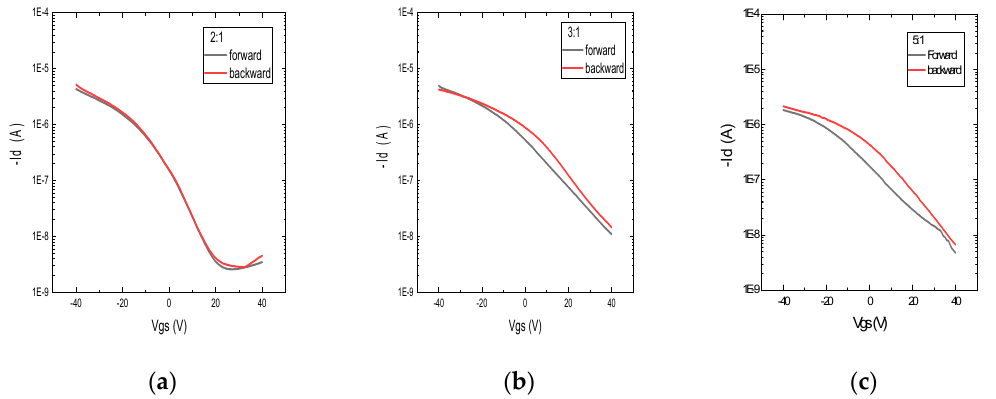
Figure 6. Transfer characteristics showing hysteresis in gate threshold voltage by forward (on